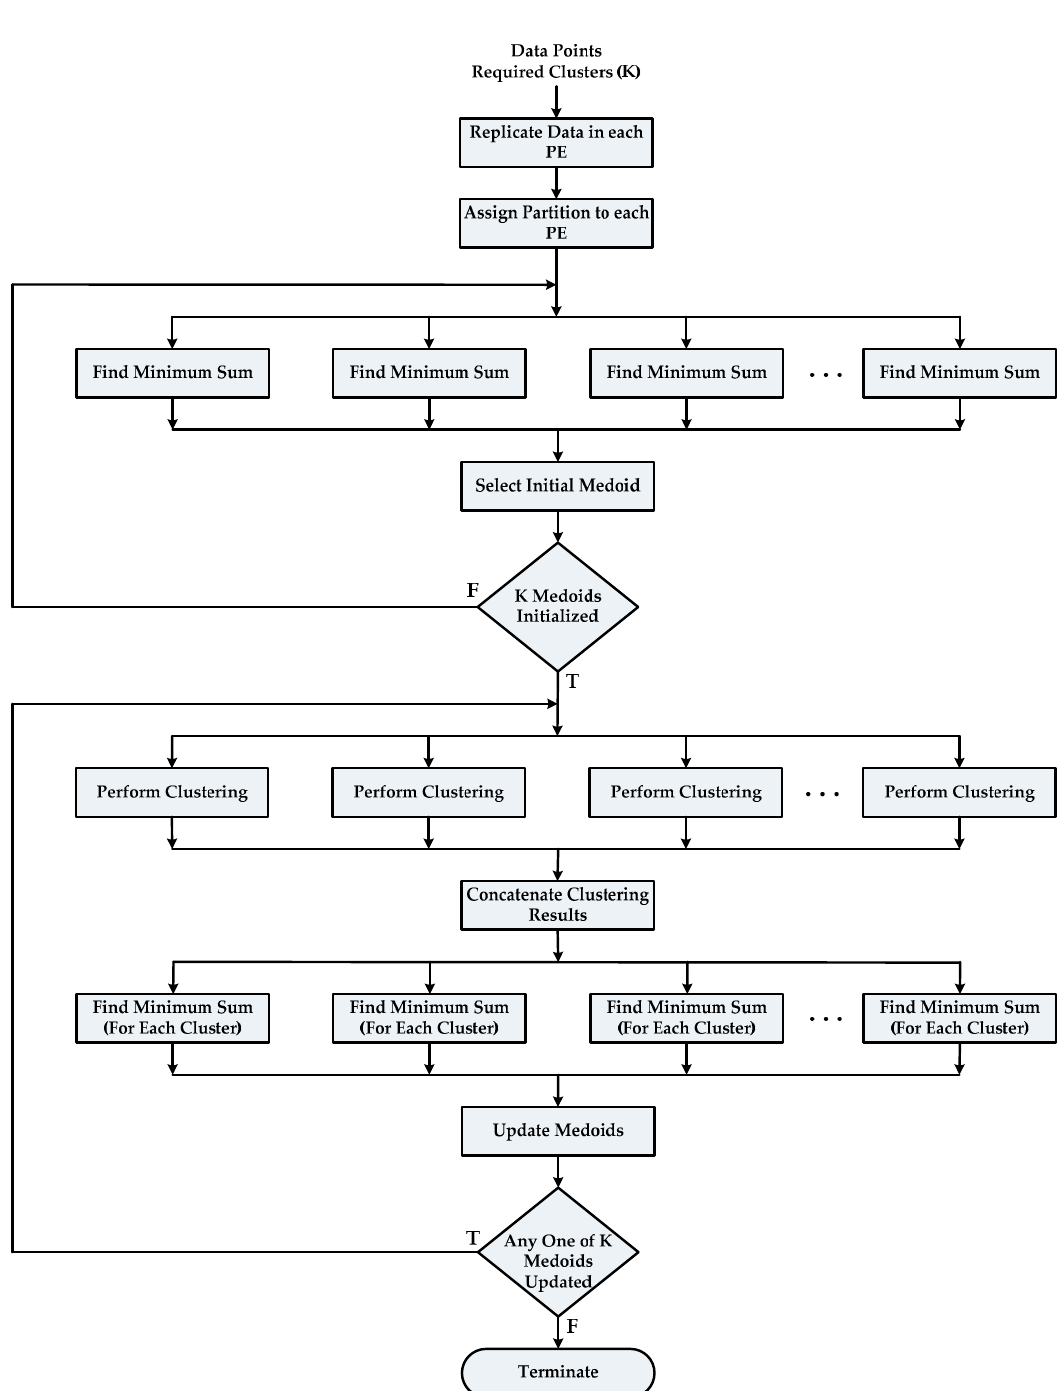
Figure 3. Flow chart of the parallel PAM algorithm.